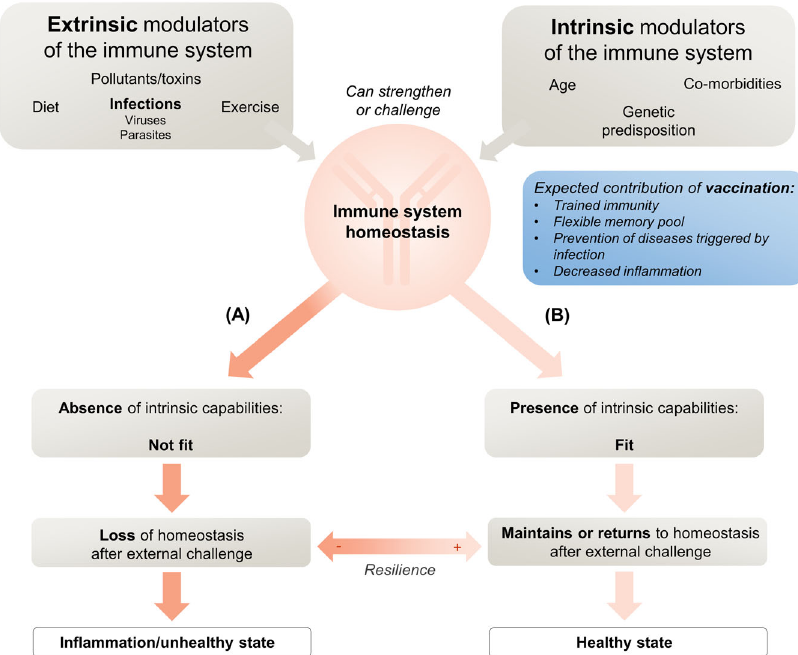
Fig. 4 Intrinsic and extrinsic modulators of immune fi tness. Intrinsic and extrinsic modulators may either challenge or strengthen the immune system. External challenges can result in either A the loss in immune system homeostasis (unhealthy state) in the absence of intrinsic capabilities or B the maintenance of homeostasis in the presence of intrinsic capabilities (healthy state). Vaccination may potentially have a positive in fl uence through trained immunity, by creating a fl exible memory pool, by direct and indirect prevention of diseases triggered by infections and associated in fl